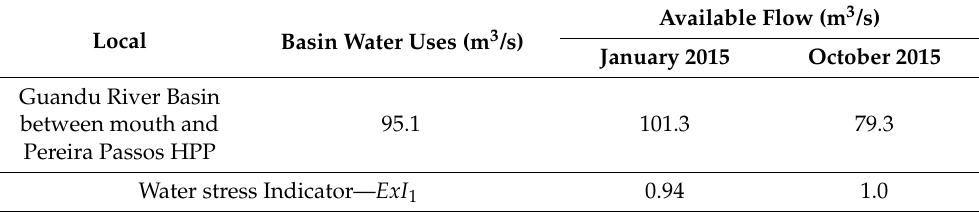
Table 11. Water stress indicator ( ExI 1 ) application.